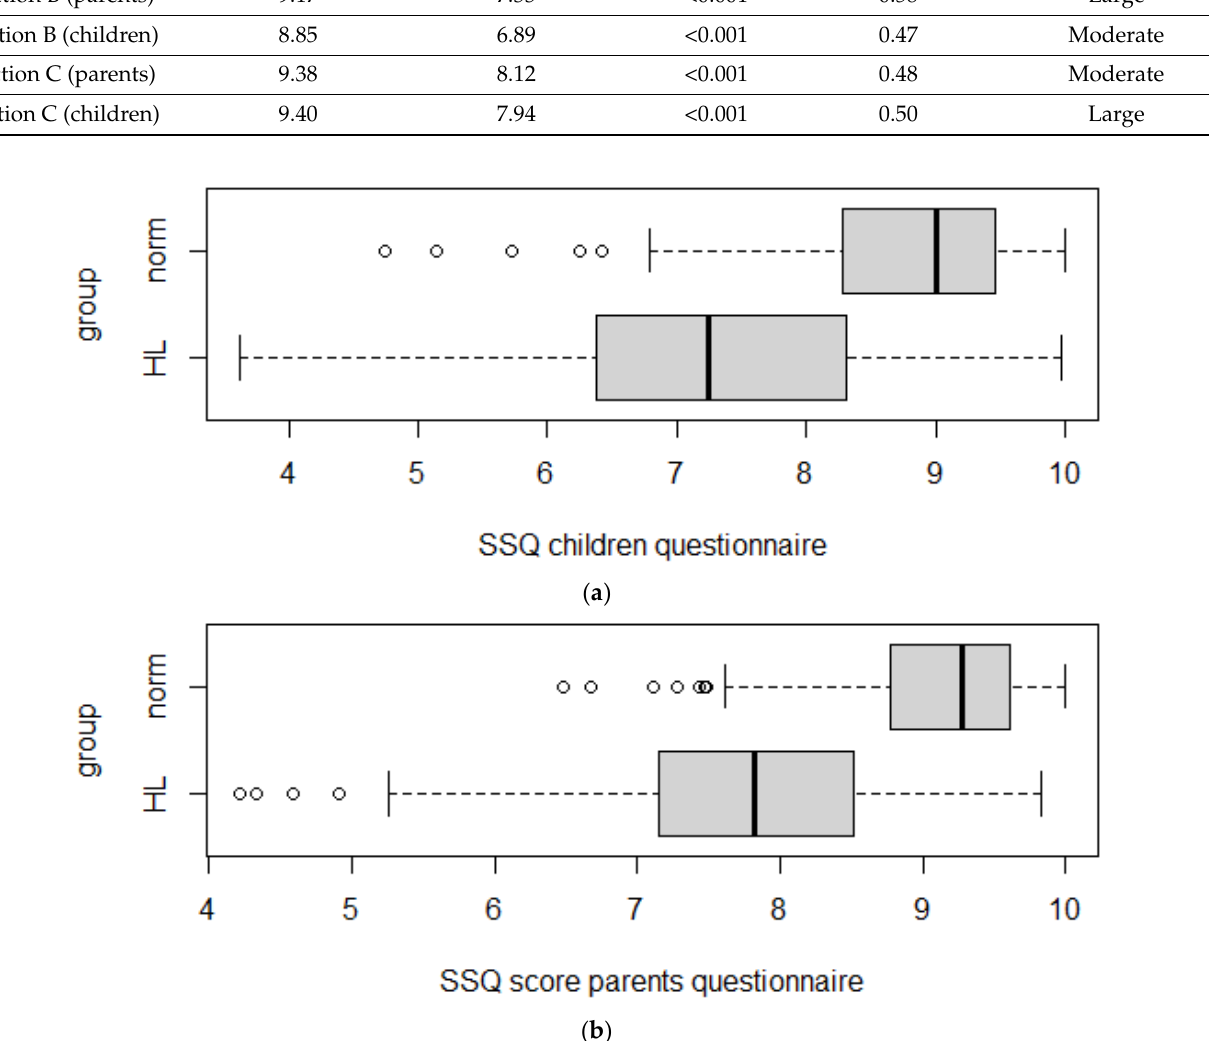
Figure 1. Boxplots of SSQ for children and for parents total scores in normal-hearing and hearing- impaired children. ( a ): SSQ children questionnaire; ( b ): SSQ score parents questionnaire.